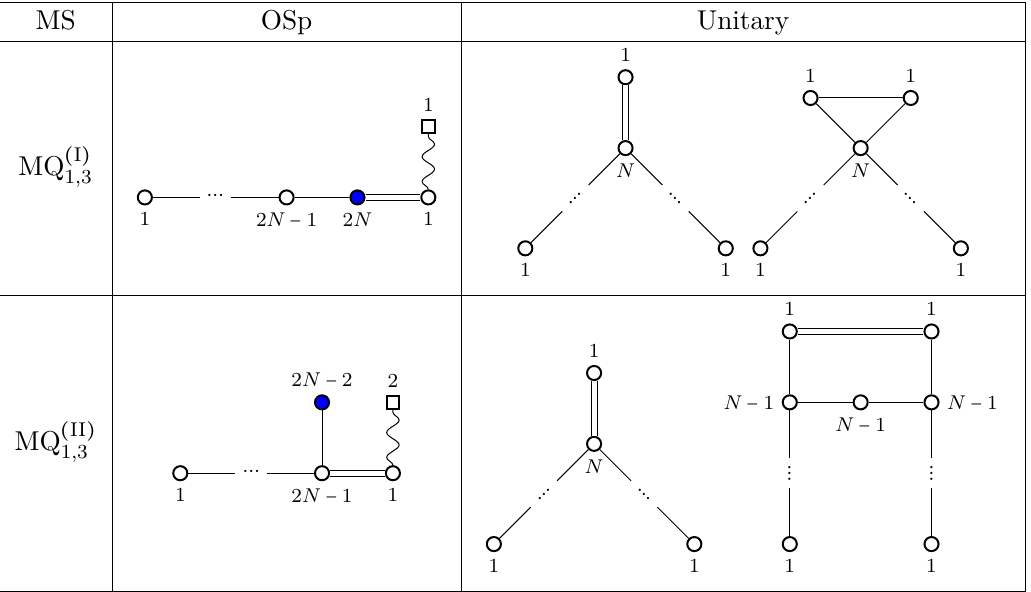
Table 2. OSp and unitary representation of the two cones on the Higgs branch of EQ unitary quivers appearing in the extreme right of the two rows of the table are respectively MQ ( I ) and MQ ( II ) 3